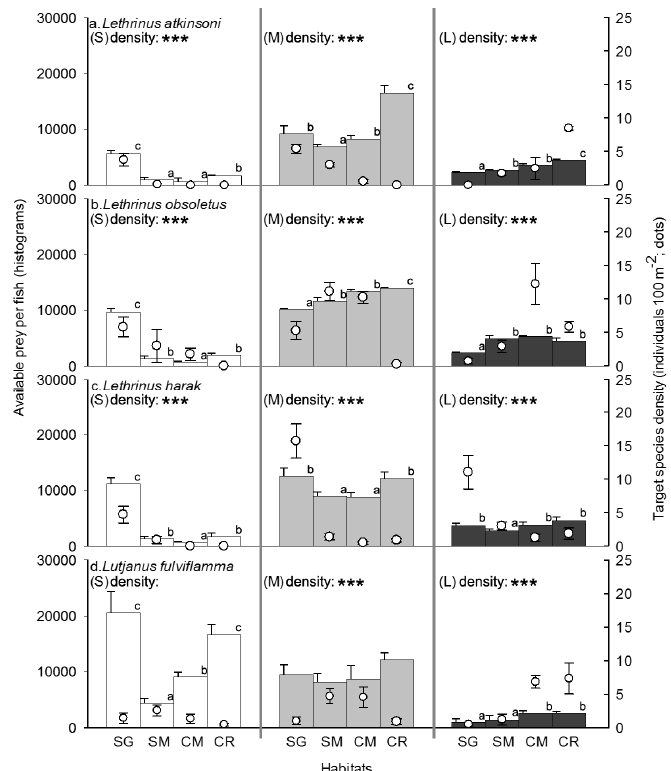
Figure 5. Available prey (histograms and left axes) and densities (dots and right axes) for the four target species—( a ) Lethrinus atkinsoni , ( b ) Lethrinus obsoletus , ( c ) Lethrinus harak , and ( d ) Lutjanus fulviflamma —in three body length categories (S: small, M: medium, and L: large). The values represent means ± SE. The letters above the histograms denote the pairwise differences (*** p < 0.001) in available prey if an overall difference was detected in the PERMANOVA model. The abbreviations for the four habitats can be found in Table 1.